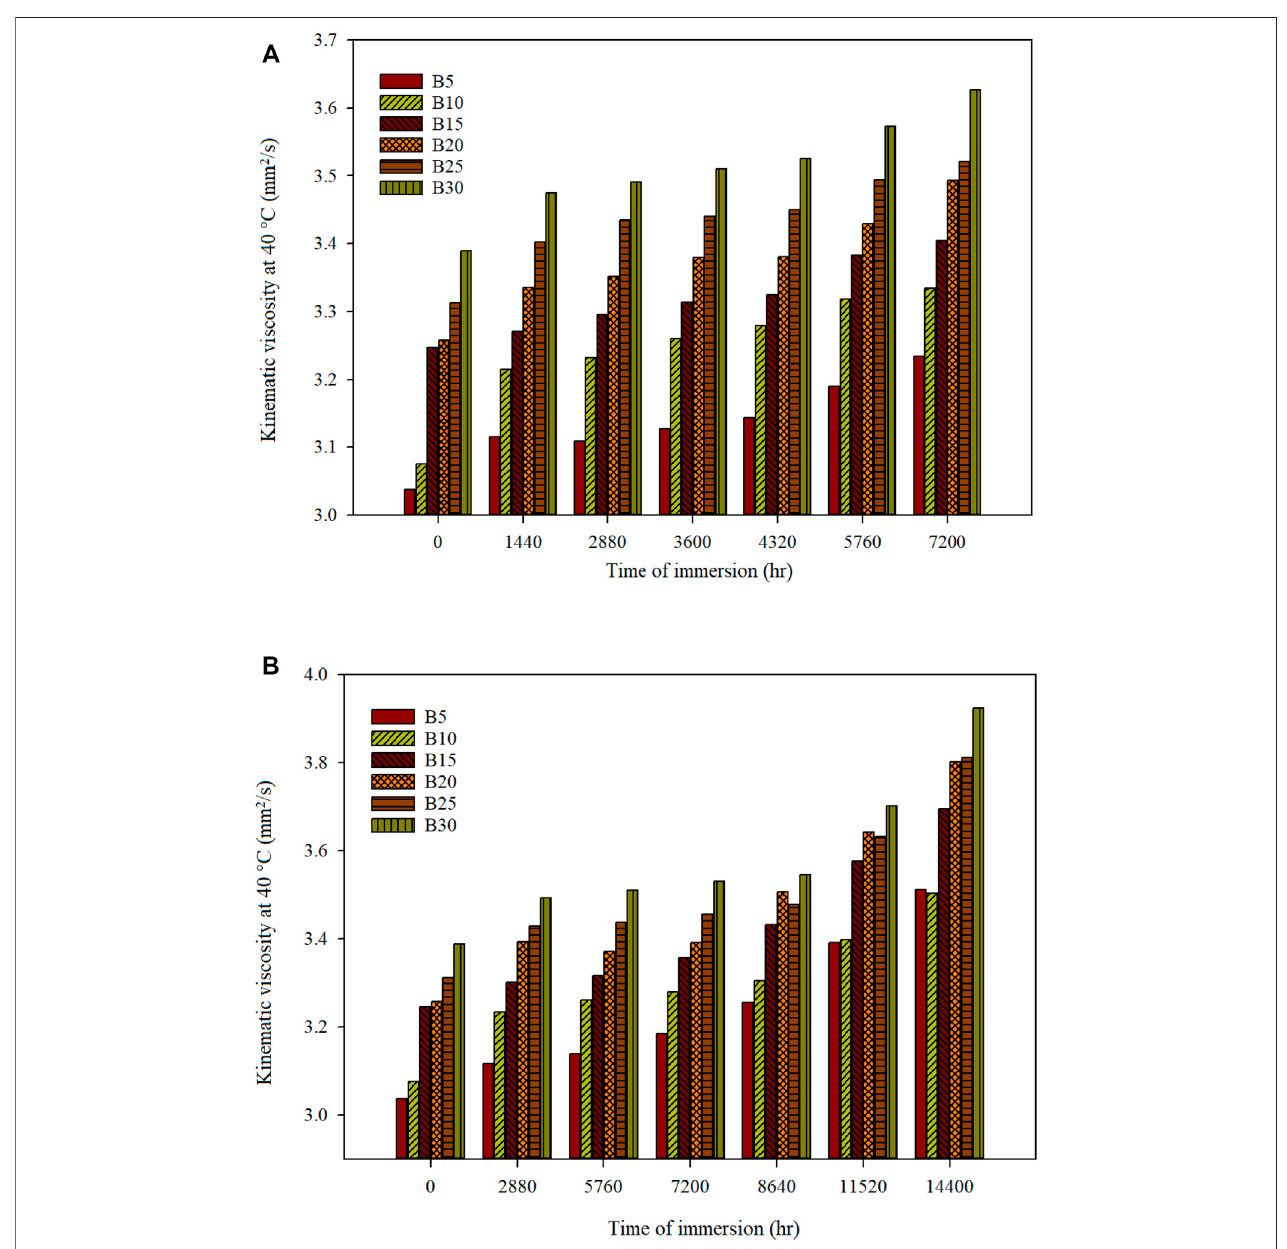
FIGURE 4 | Kinematic viscosity at 40 ° C of different biodiesel-diesel blending ratios for (A) mild steel and (B) stainless steel 316 for a speci fi c time of immersion.